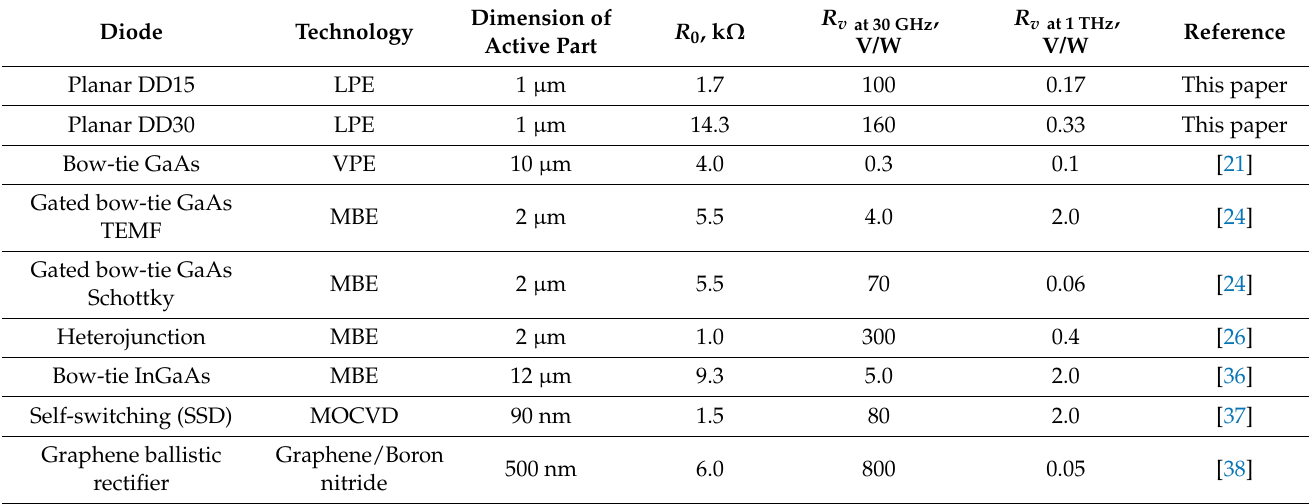
Table 7. Parameters of several different millimeter wave diodes operating at room temperature without bias